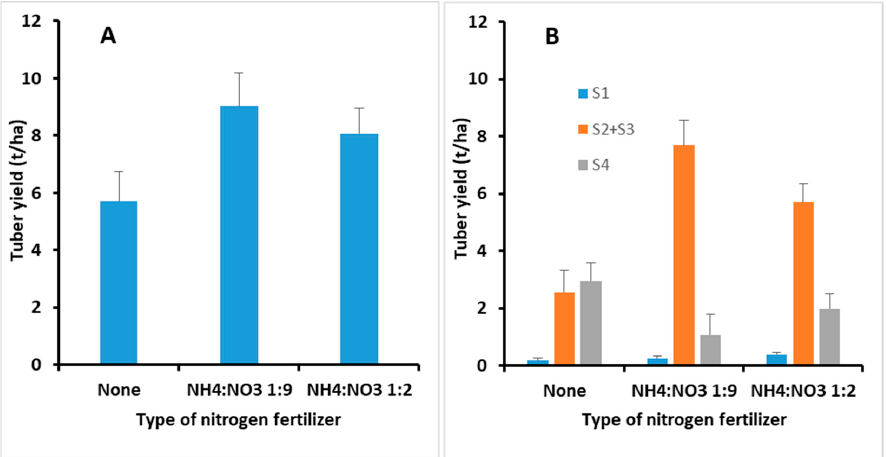
Figure 3. Effects of composite N-P-K fertilizer application (seasonal doses of 300, 190, and 450 kg ha − 1 of N, P 2 O 5 , and K 2 O, respectively), comparing two different ammonium:nitrate ratios on total tuber yield ( A ), and on tuber distribution according to size, quality, and age ( B ). Tubers were sorted according to Figure 1. Bars indicate SE.